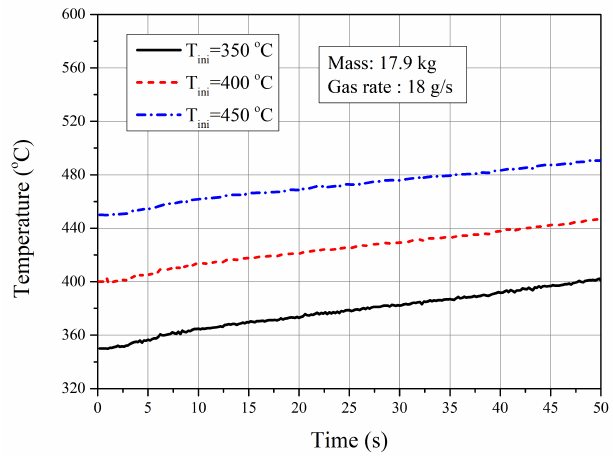
Figure 13. Profile of time evolution of gas temperature with different initial